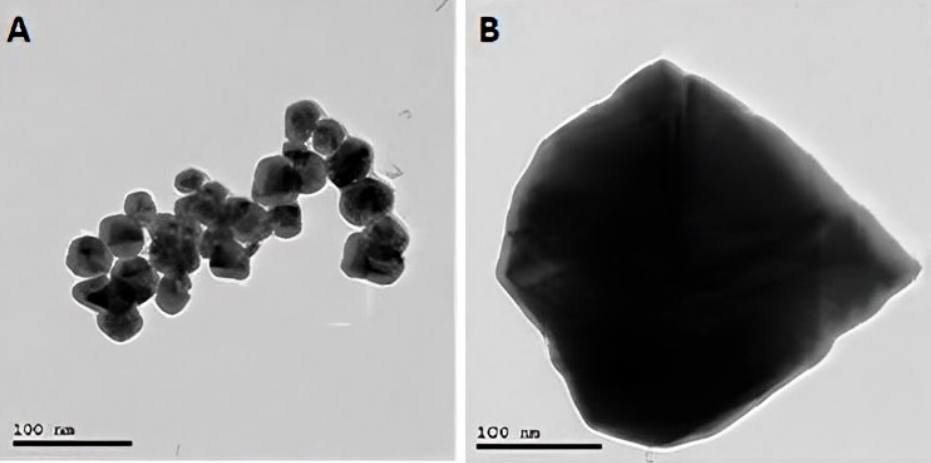
Figure 3. TEM image of silver nanoparticles ( A ) and bulk silver ( B ).